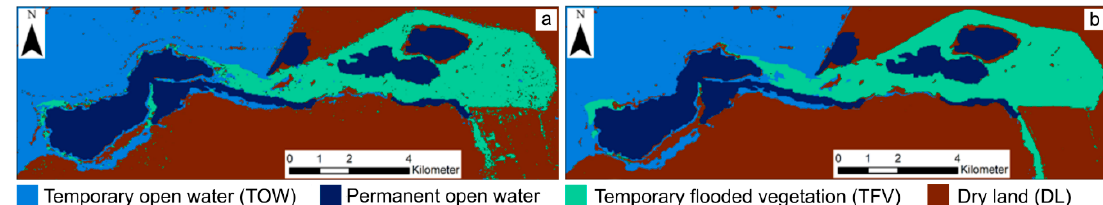
Figure 10. Pixel-based classification result ( a ), object-based classification result ( b ) for the study area in southern Greece/Turkey.